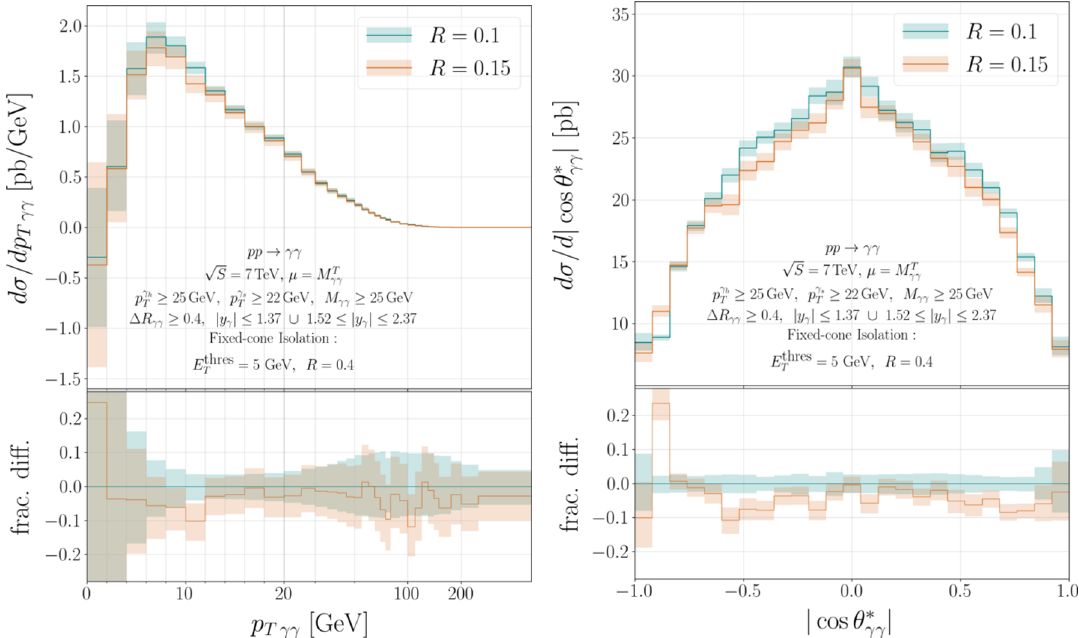
JHEP04(2021)041